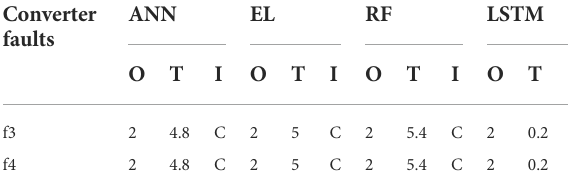
TABLE 7 Performance results during the converter